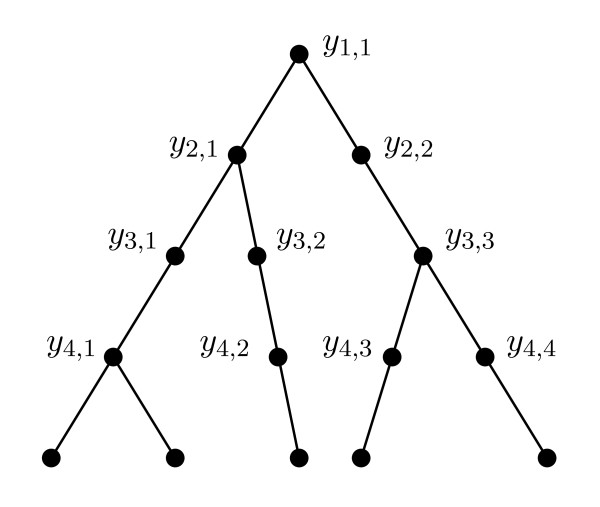
The beaded version of the species tree topology in Figure1a–d.